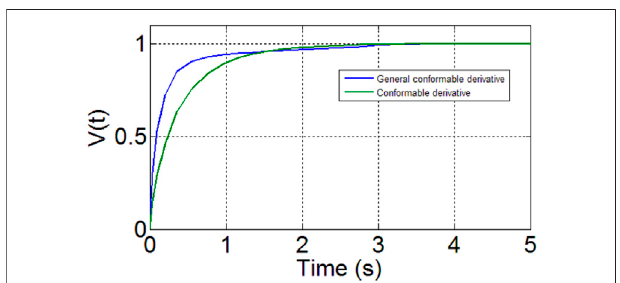
FIGURE 1 | Evolution of V ( t ) with α (cid:2) 0 . 8.